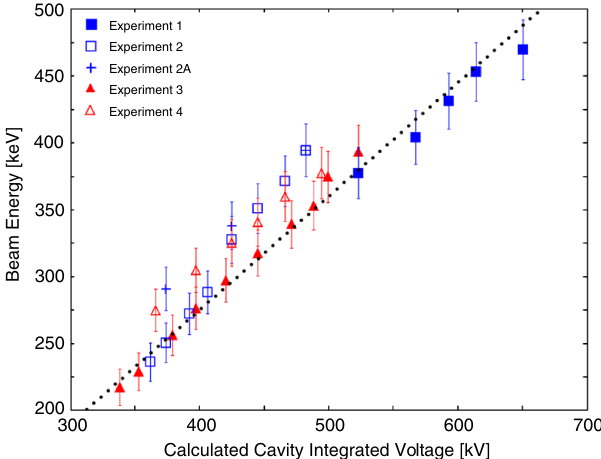
FIG. 17. Beam energy as a function of cavity integrated volt- age associated with the fundamental mode, calculated from measurements of the transmitted power, for two cathode loca- tions. Error bars are estimated by summing in quadrature the errors associated with the dipole magnetic field strength and the estimated (cid:2) 0 : 5 cm precision of centering the beam centroid on the downstream YAG screen. The trend line slope is